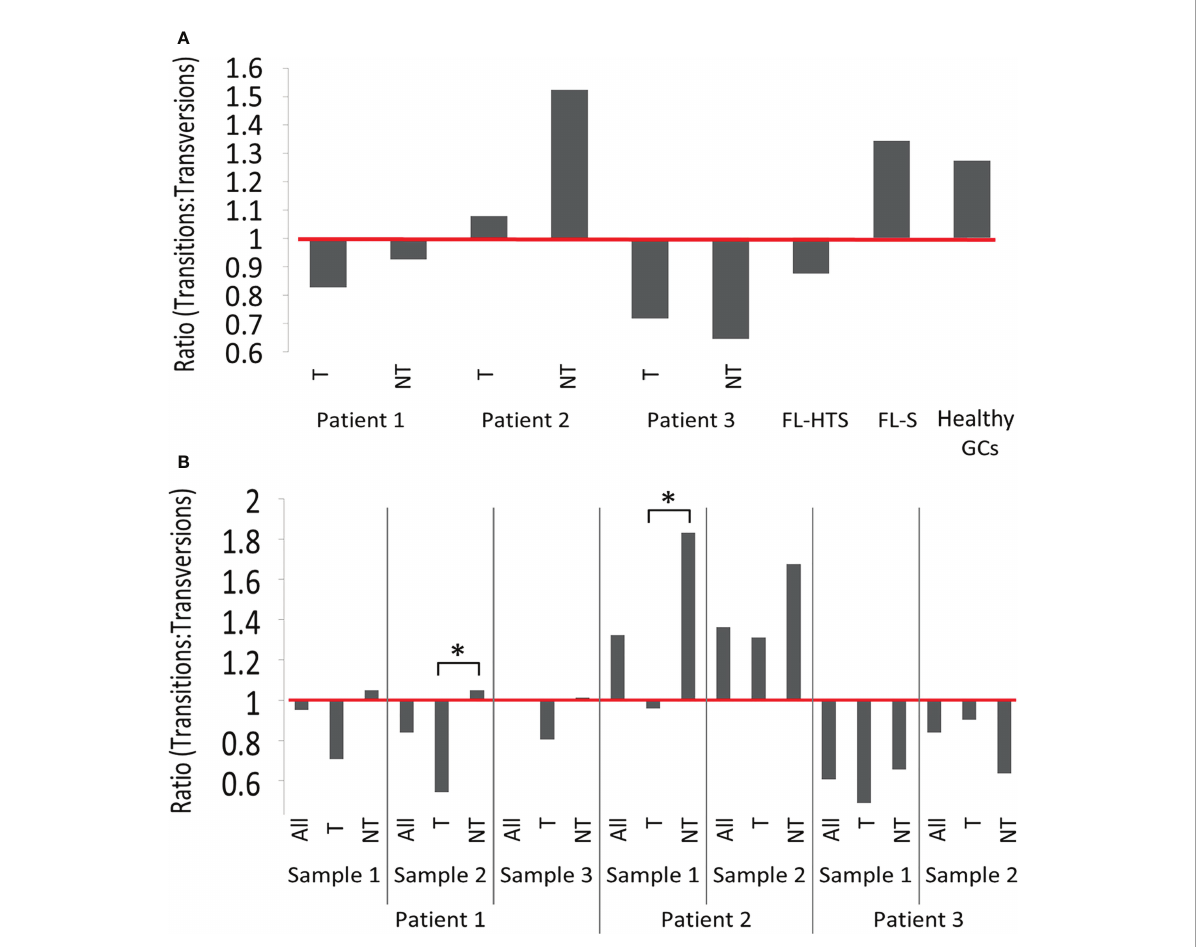
FIGURE 2 Transition-transversion mutation ratios. (A) In tumor and non-tumor clones per patient analyzed and (B) In tumor and non-tumor clones per sample. Additional information regarding the numbers of transition and transversion mutations in tumor and non-tumor clones of FL patients, and in healthy GCs are provided in the Tables S7 and S8. According to the c ² test, no signi fi cant differences were observed between tumor and non-tumor clones across different patients. Signi fi cant differences were found when tumor and non-tumor clones from sample 2 from patient 1 and sample 1 from patient 2 (*p-value < 0.005) were compared. (See also Tables S7 and